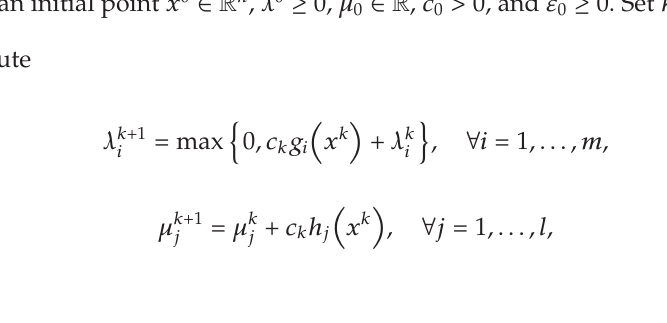
Algorithm 2.1 (cid:3) Multiplier algorithm based on L (cid:4)